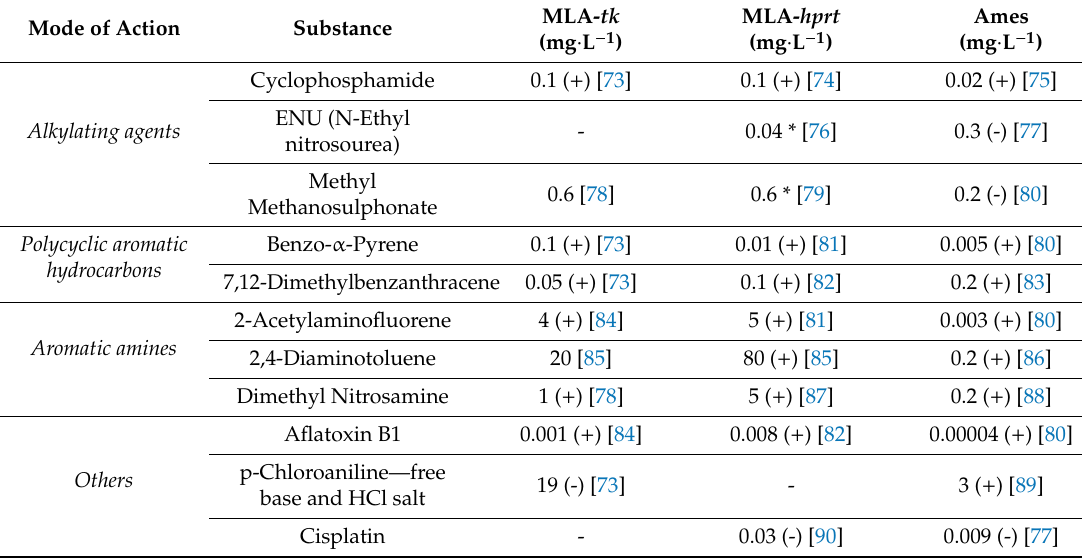
Table 2. Calculated limit of biological detection (cLOBD) for genotoxic substances that result in gene mutations as found in a literature survey for commonly used in vitro assays for detecting gene mutations with the global concentration factor (GCF) of 10 taken into account for mammalian assays and a GCF of 40 for the Ames test.